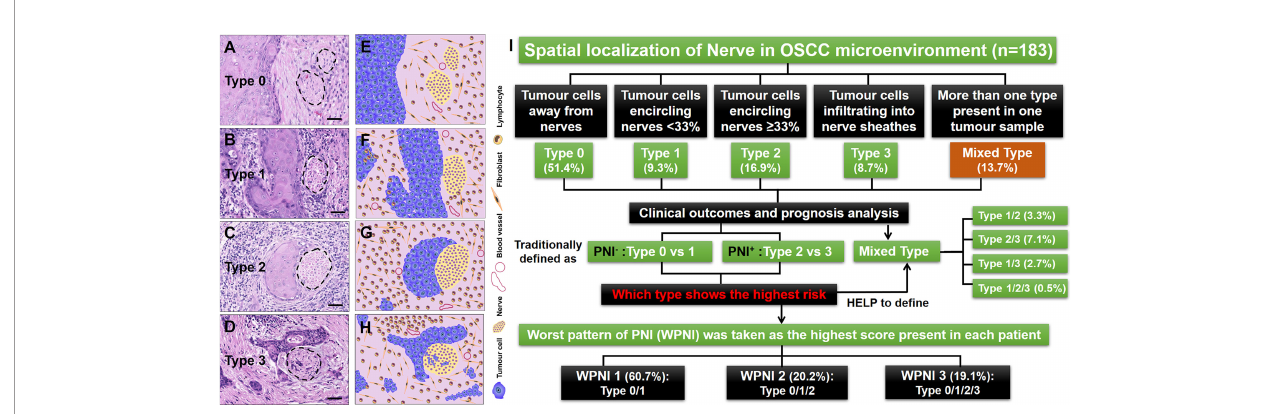
FIGURE 1 | Illustrations for patterns of tumor-nerve interaction and the study design. (A) PNI type 0, tumor cells away from nerves. (B) PNI type 1, tumor cells encircling nerves less than 33%. (C) PNI type 2, tumor cells encircling nerves at least 33%. (D) PNI type 3, tumor cells in fi ltrating into nerve sheathes. (E – H) The cartoon diagrams corresponding to (A – D) . (I) Flow diagram illustrating the management of OSCC patients strati fi ed by different types of PNI. The dashed circles represented the peripheral nerves. Scale bars: 20 m